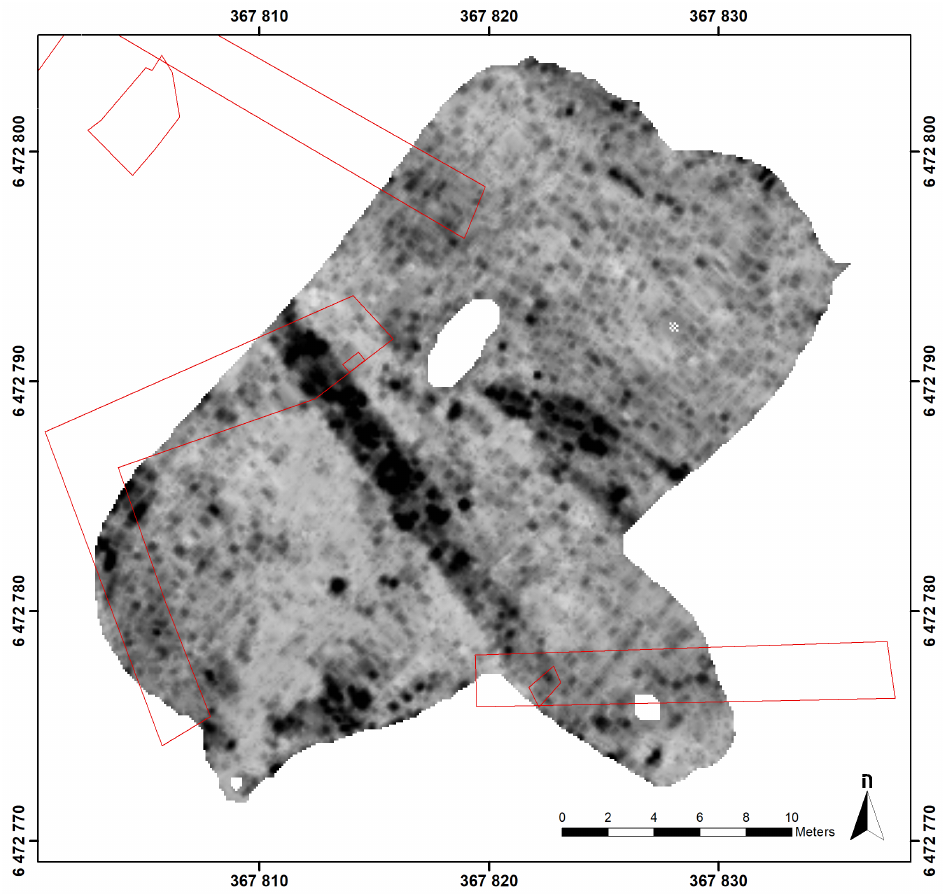
Figure 6. The GPR depth-slice (15–55cm depth) from Field A at Gausdal clearly showing the anomaly caused by the buried remains of the old stone-paved road as a 2m wide, strongly reflective linear structure running in the NW-SE direction. The red marked areas show the location of the excavation trenches. Coordinates are in ETRS 1989 UTM